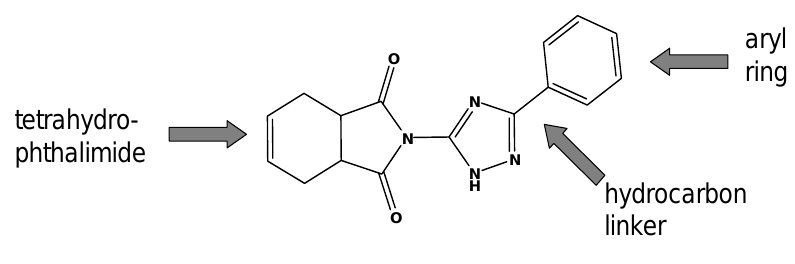
Figure 8. Points of variation for SAR of